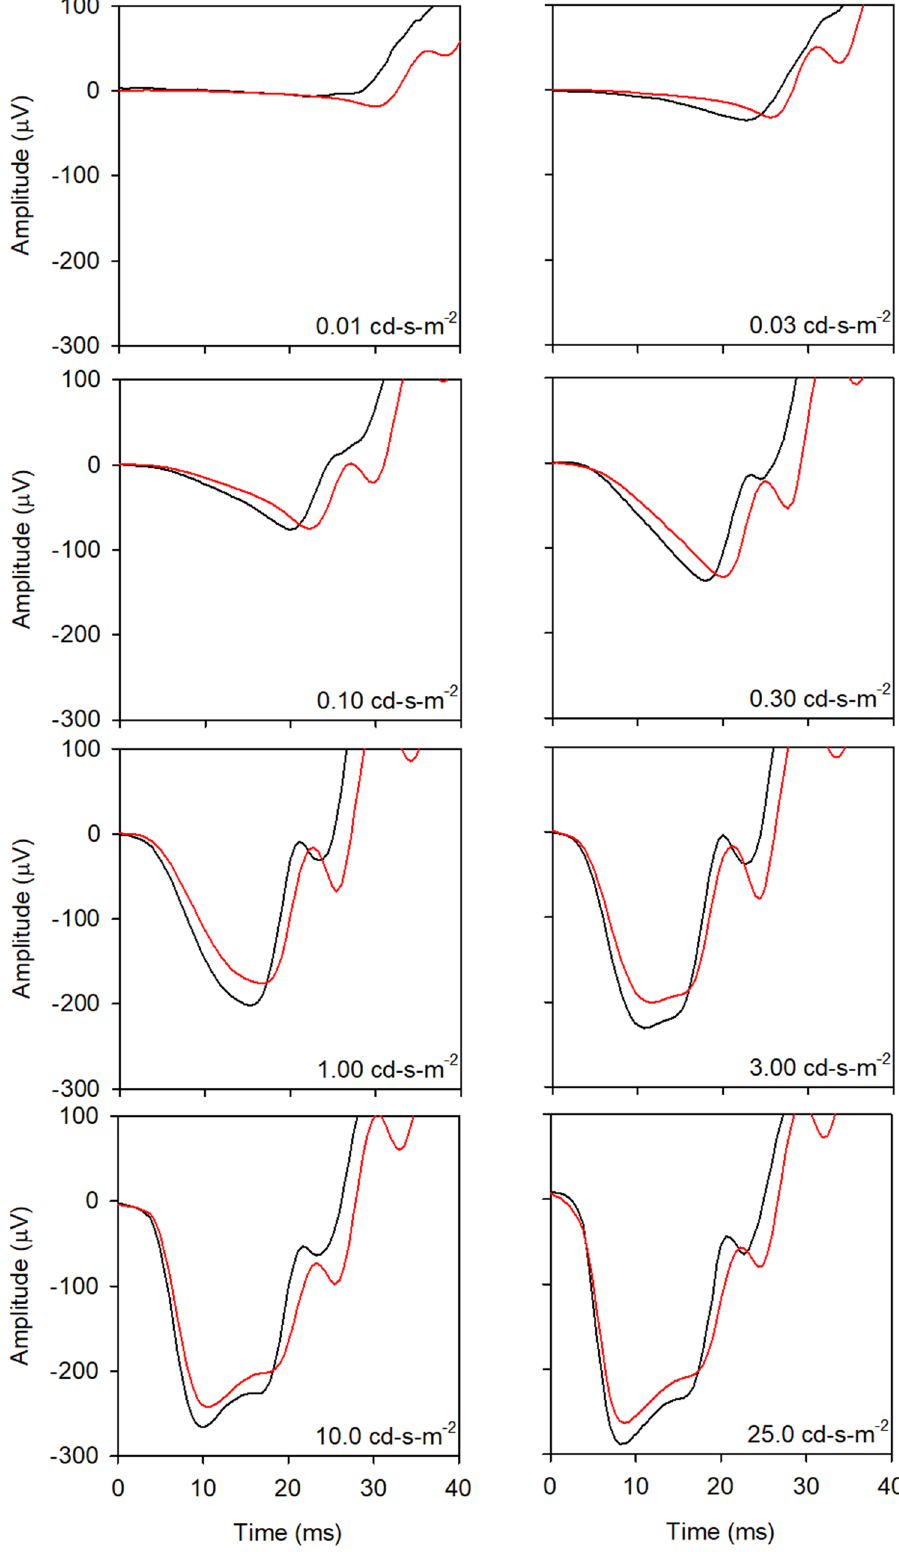
Figure 3. Mean waveforms at each flash luminance are replotted from Fig. 1 on expanded time and amplitude scales to highlight the a-waves. All other conventions are as in Fig.